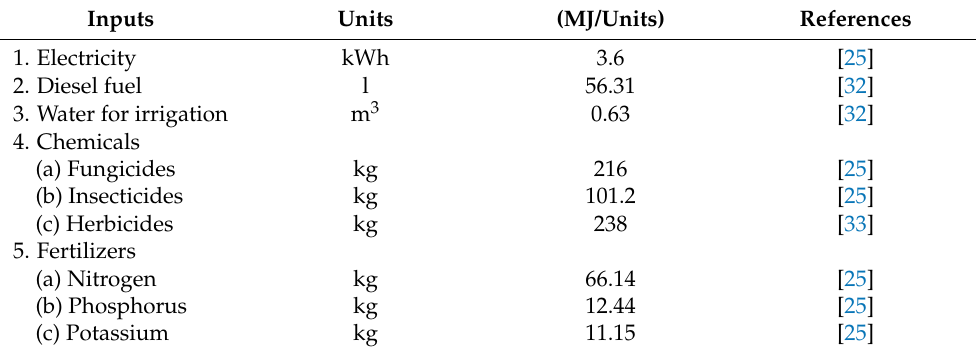
Table 1. Energy equivalents for the different inputs (Reproduced with permission from Dermican et al., Energy Conversion and Management; published by Elsevier, 2016